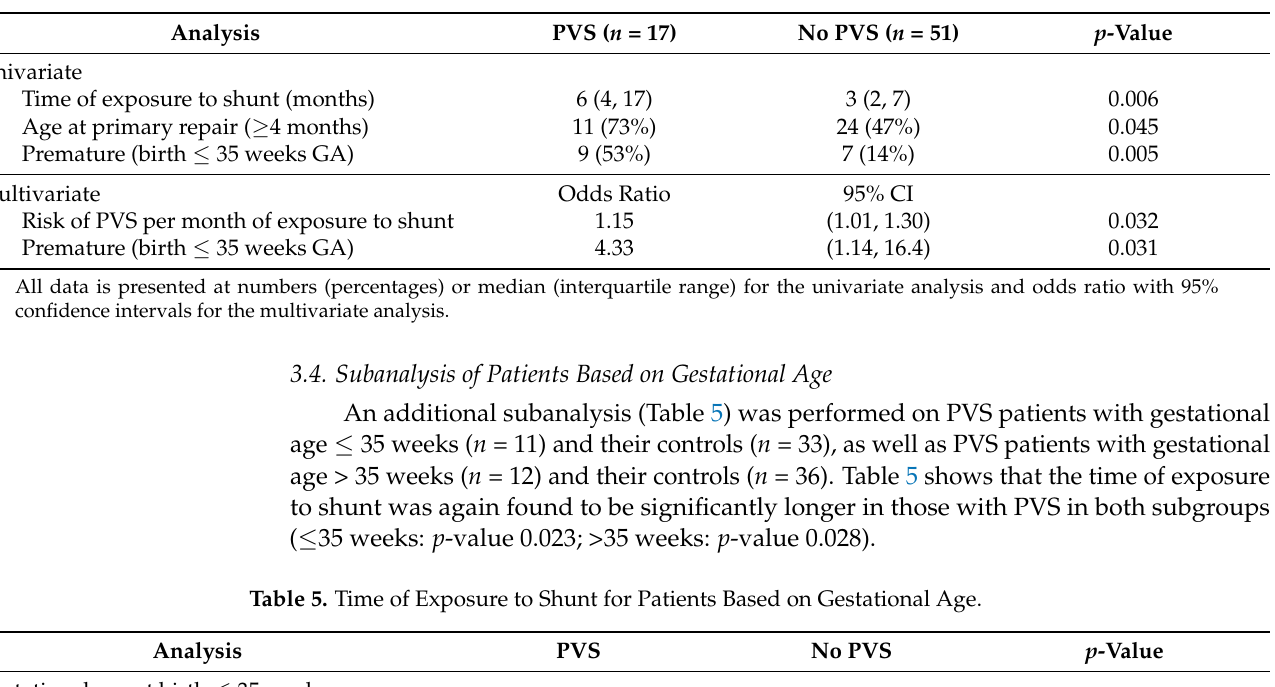
Table 4. Subanalysis of Patients with Multivessel Pulmonary Vein Stenosis.